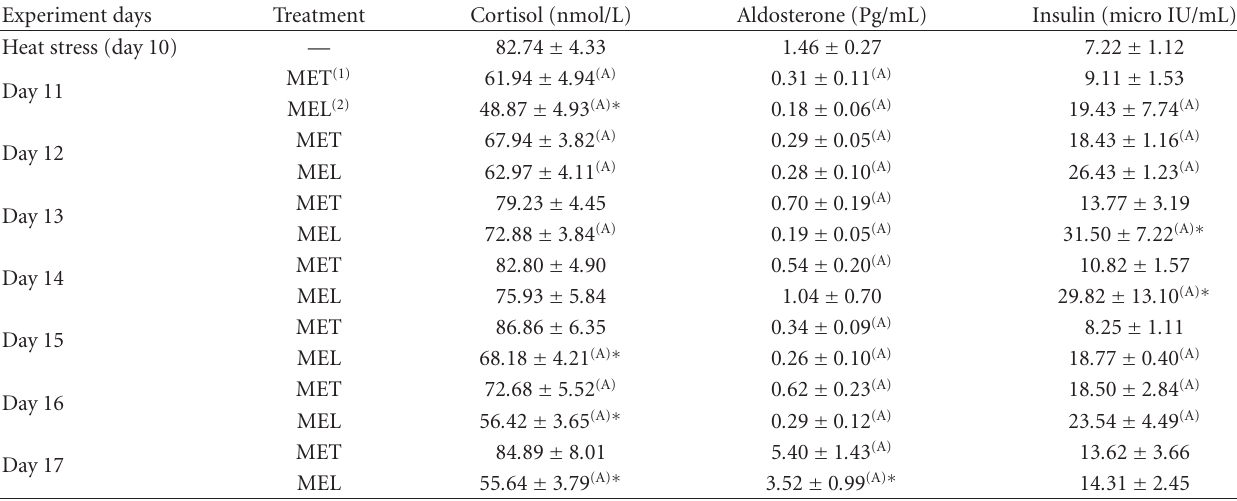
Table 3: Mean and SE of cortisol, aldosterone, and insulin in blood plasma of heat exposed, chemically adrenalectomized, and melatonin administered goats. Values are mean and